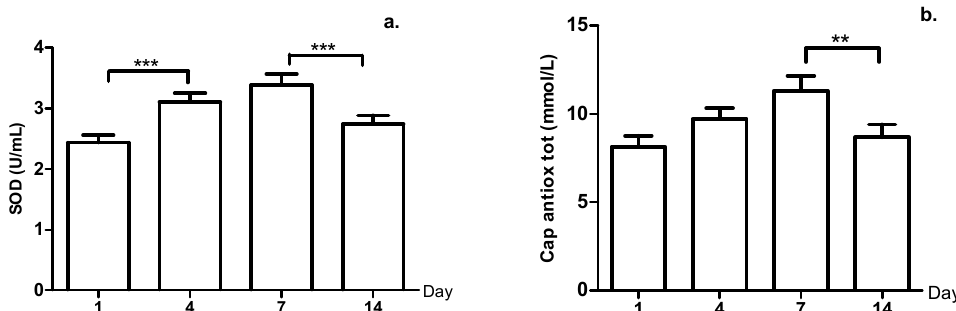
Figure 1. ( a ) Superoxide dismutase (SOD) levels. ( b ) Total antioxidant capacity (Cap antiox tot) during the micro-cycle, **: p -value < 0.01, ***: p -value < 0.001.